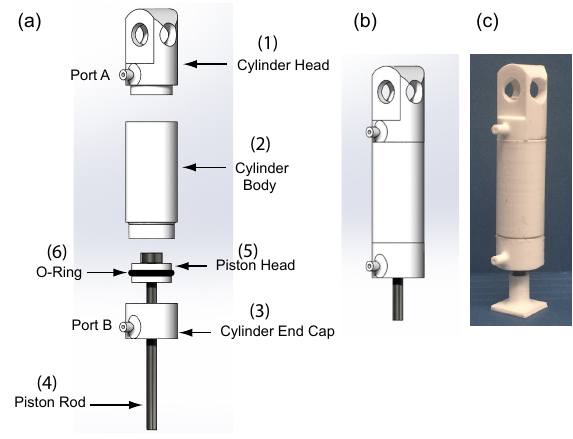
Figure 1. An Overview of the 3D printed actuator: ( a ) an exploded view, ( b ) assembled view, and ( c ) 3d printed and assembled.